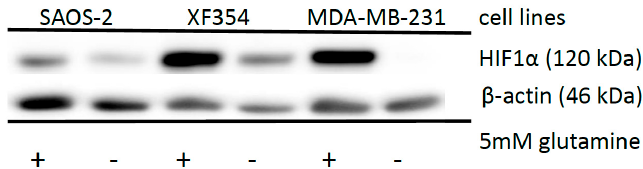
Figure 2. E ff ects of glutamine application on HIF1 α expression in di ff erent tumor cell lines. Saos-2, XF354 and MDA-MB-231 cells were left untreated or treated with 5 mM glutamine in RPMI 1640 medium without glutamine under normoxic conditions for 24 h followed by Western blot analysis of HIF1 α and β -actin as a loading control. Data from three independent experiments (Please see Supplemental Figure S4 and the results from the densitometric evaluation of the Western blots).